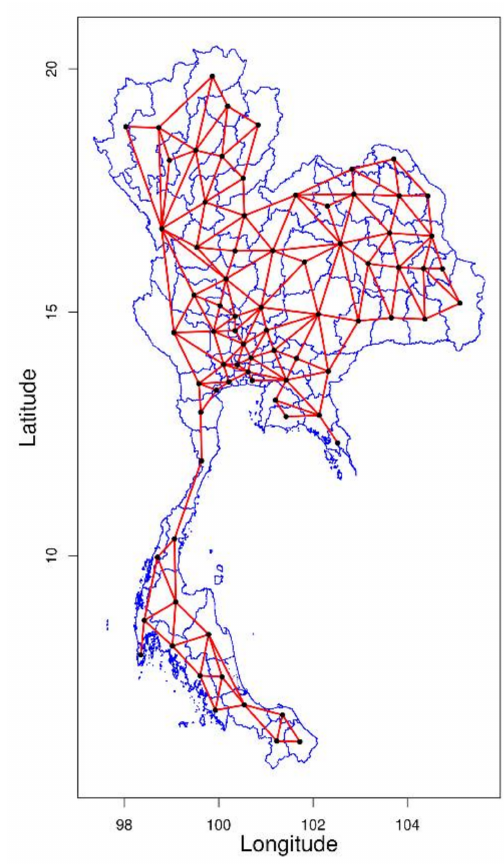
Figure 1. Map of Thailand with provincial borders (blue lines) and connected provinces from spatial contiguity matrix (black dots and red